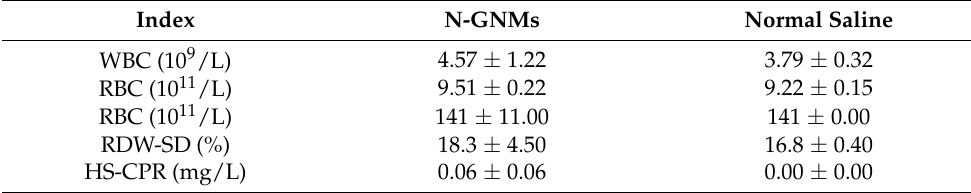
Table 1. Determination of the blood components of BALB/c